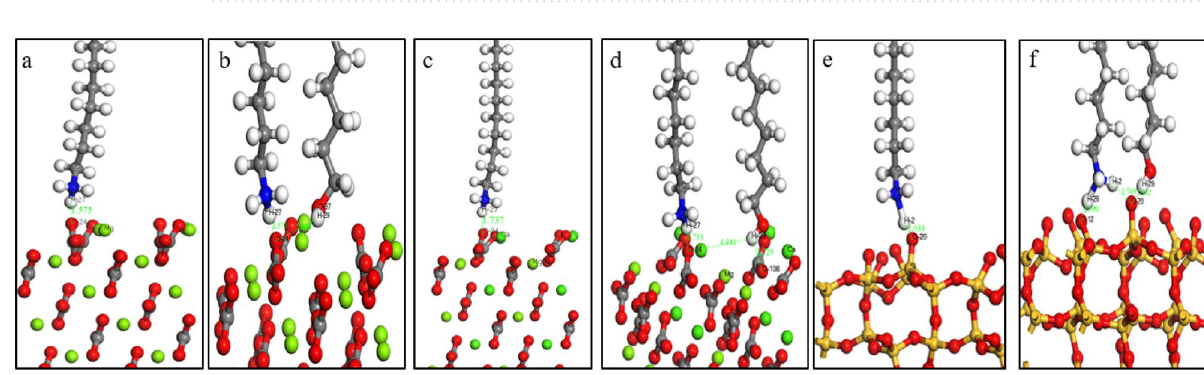
Figure 3. Unit cell model of the magnesite (101) ( a , b ), dolomite (101) ( c , d ) and quartz (101) ( e , f ) surfaces before relaxation ( a , c , e ) and after relaxation ( b , d , f ).